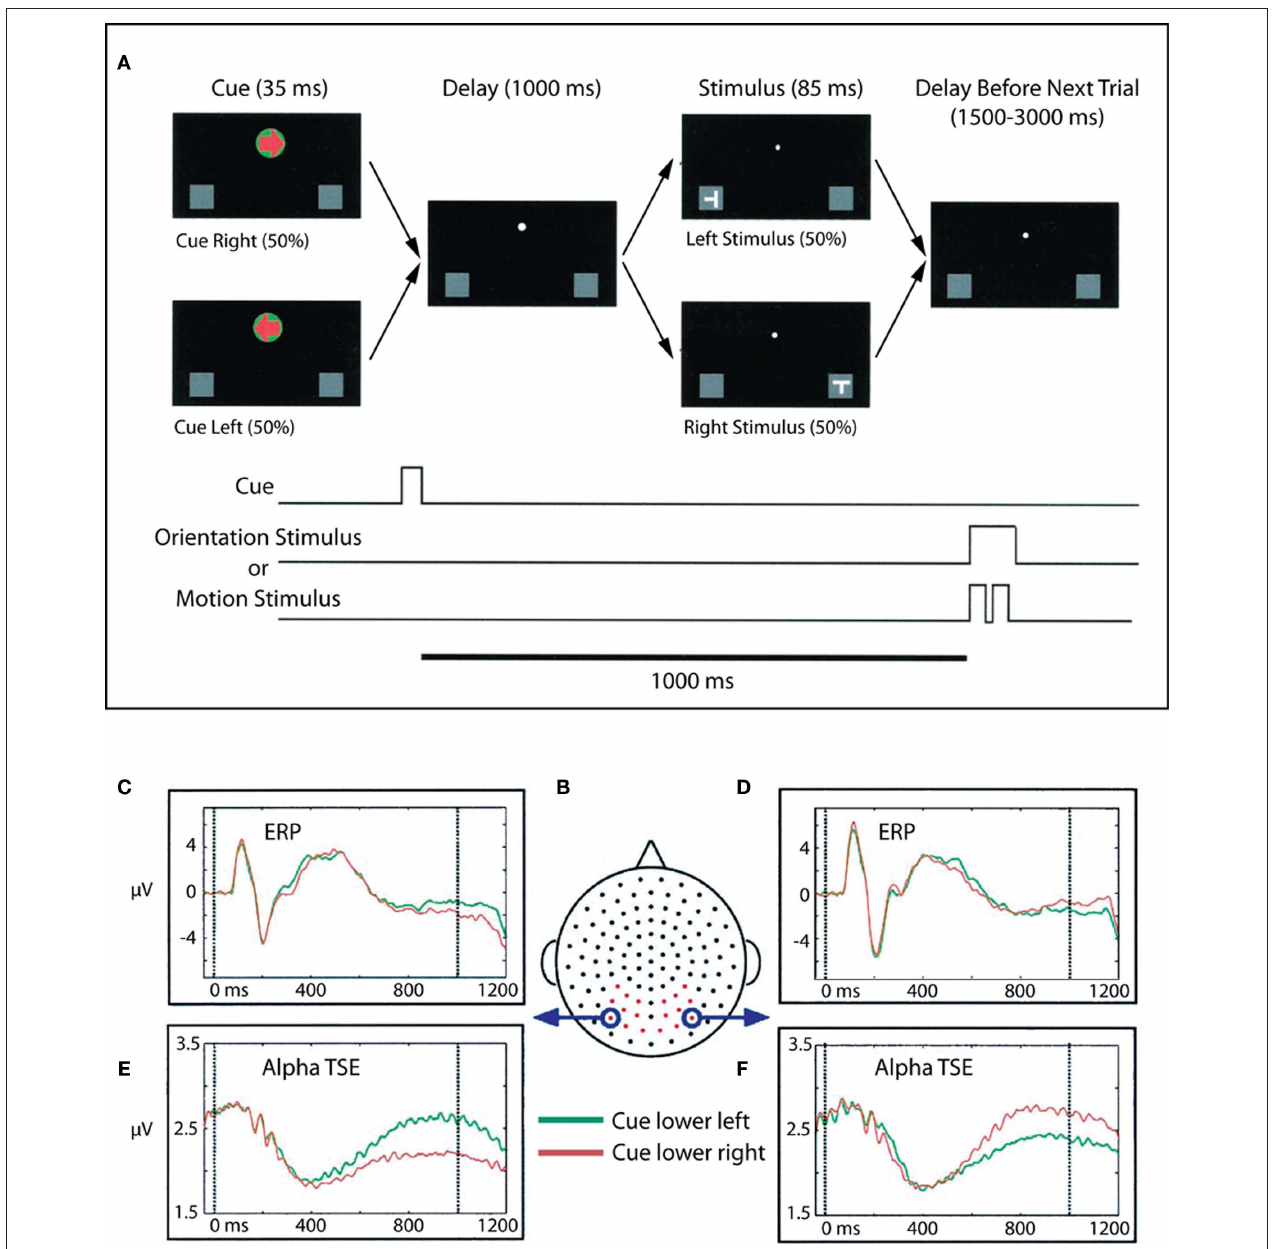
red, circled electrodes were used to generate the accompanying waveforms. (C,D) ERPs to the lower left and right cues (collapsed across motion and orientation trials) for two occipital electrode sites, averaged over 10 subjects. Data for attend lower left are plotted in green, and data for attend lower right are plotted in red. (E,F) Corresponding alpha-band (8–14 Hz) TSE waveforms for the same electrodes. A sustained divergence in TSE amplitude is seen starting at ∼ 500 ms, which depends on both the cued direction of attention and the side of recording. TSE amplitudes are larger over occipital cortex ipsilateral to the direction